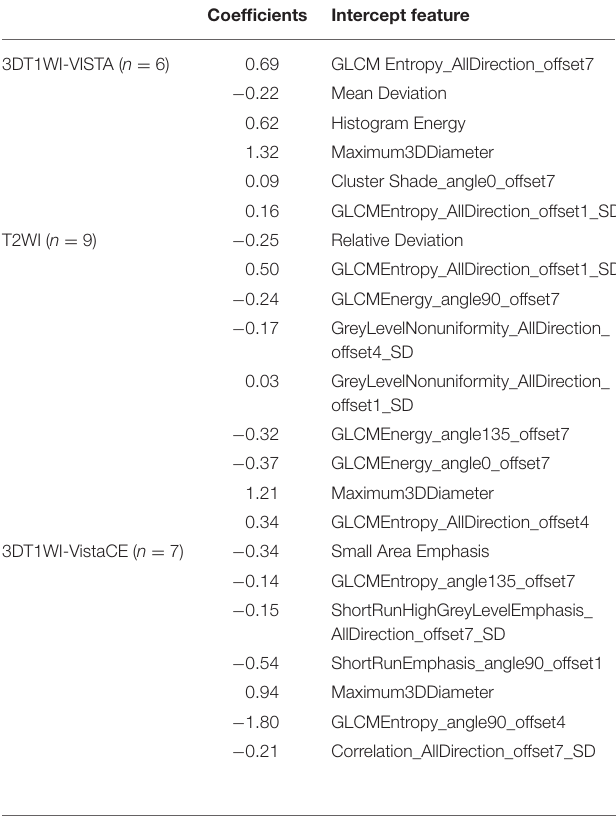
TABLE 2 | Effective intercept features for the 3DT1WI-VISTA, T2WI, and 3DT1WI-VISTA-enhanced images in SICAS.